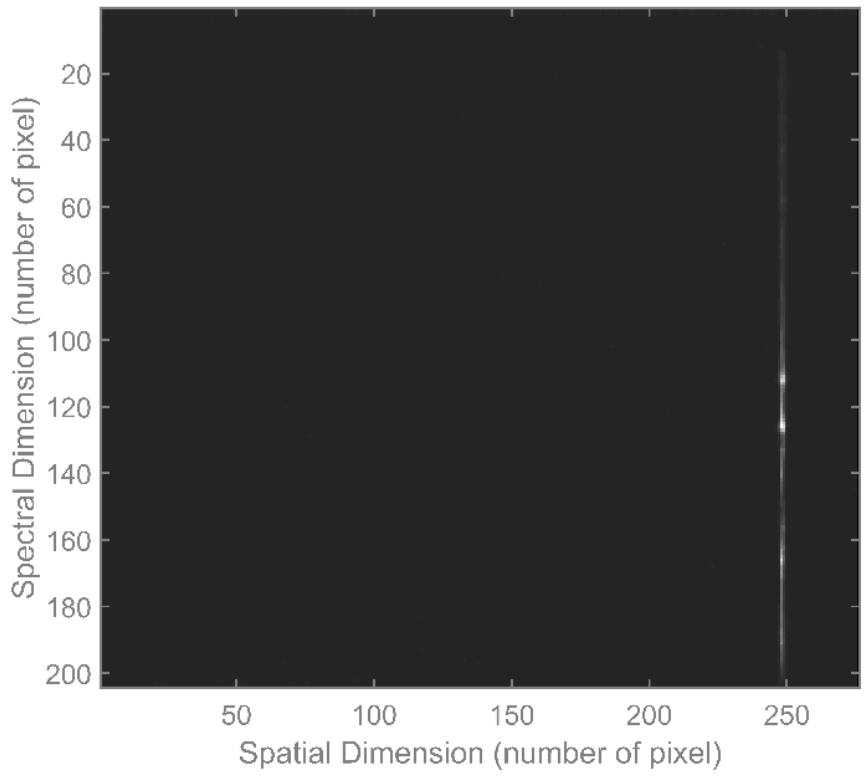
Figure 12. Corrected HARIS response at the geometric calibration of 88.57°. After correction, the instrument response becomes a straight line in the spectral dimension.